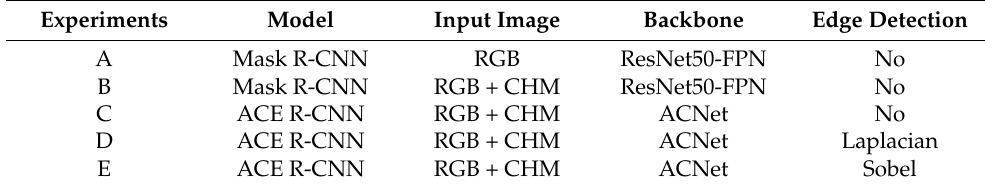
Table 4. Comparison experiments with different data input types, backbone networks, and edge detection